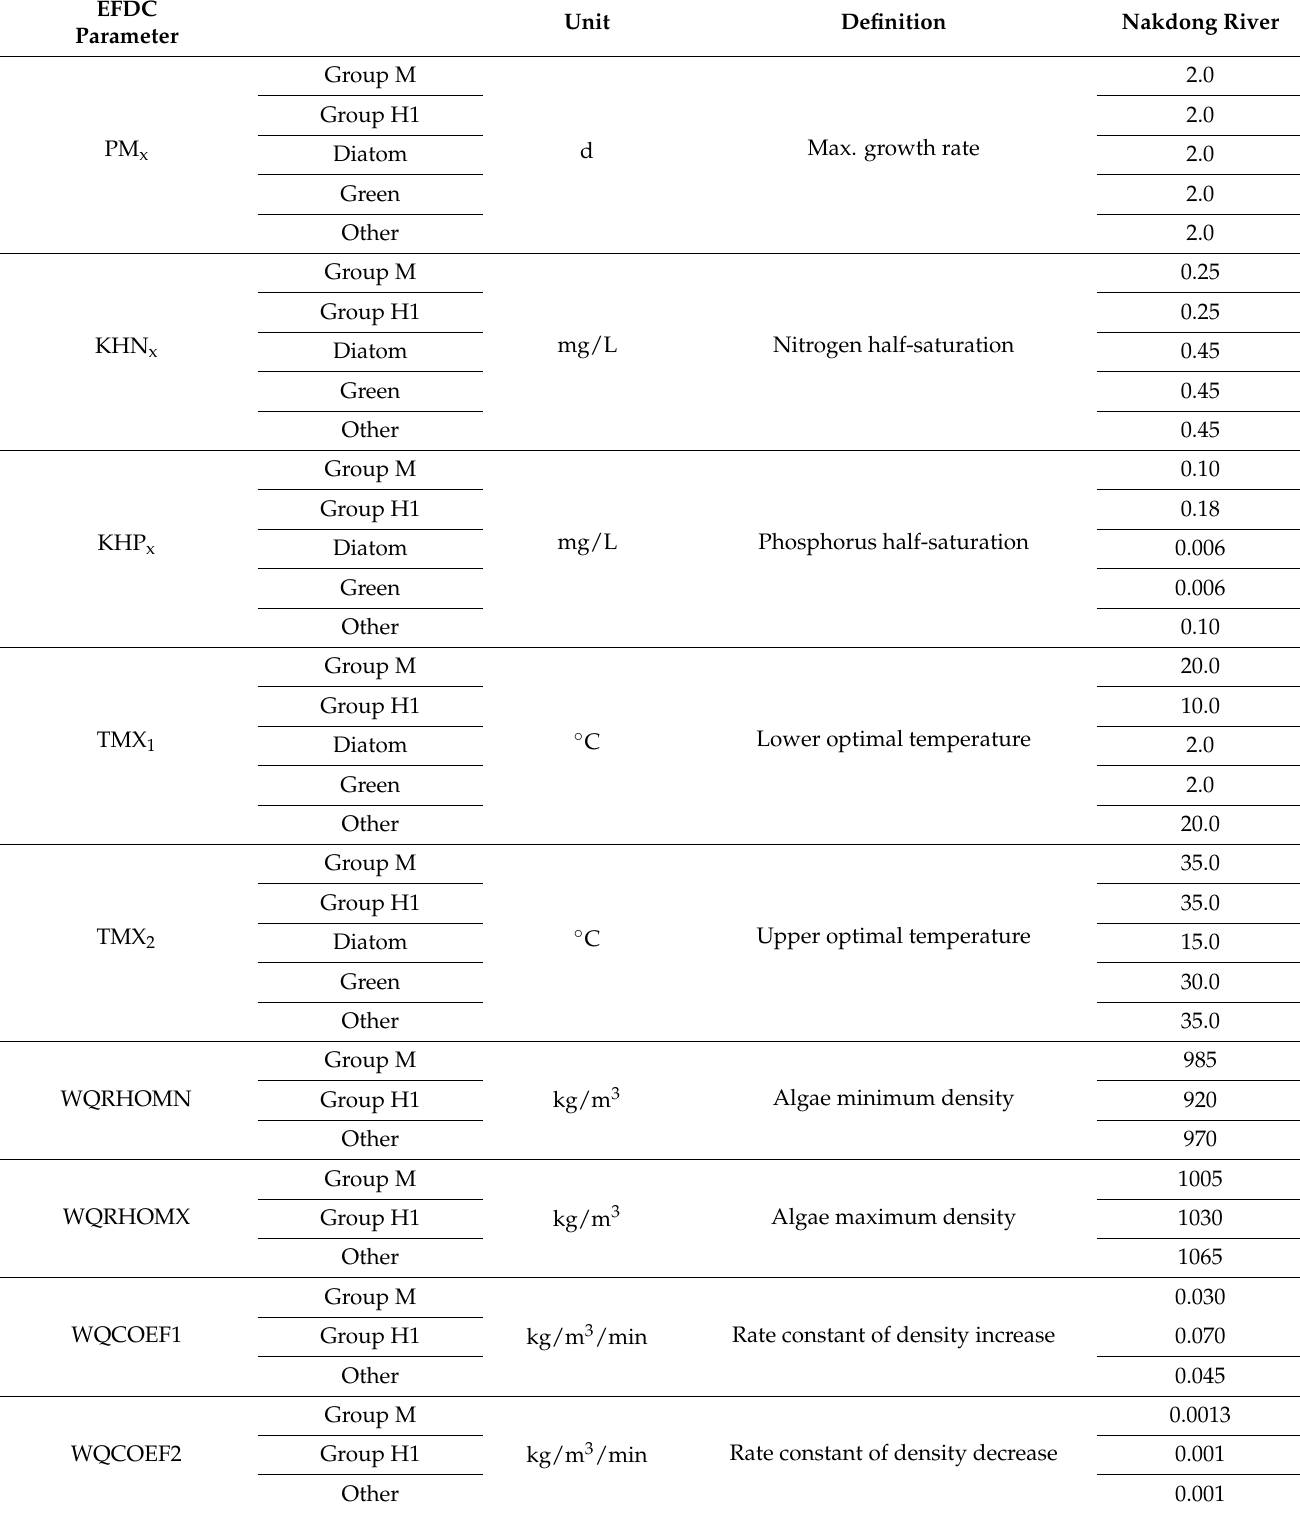
Table 4. Major parameters applied to the EFDC-NIER model